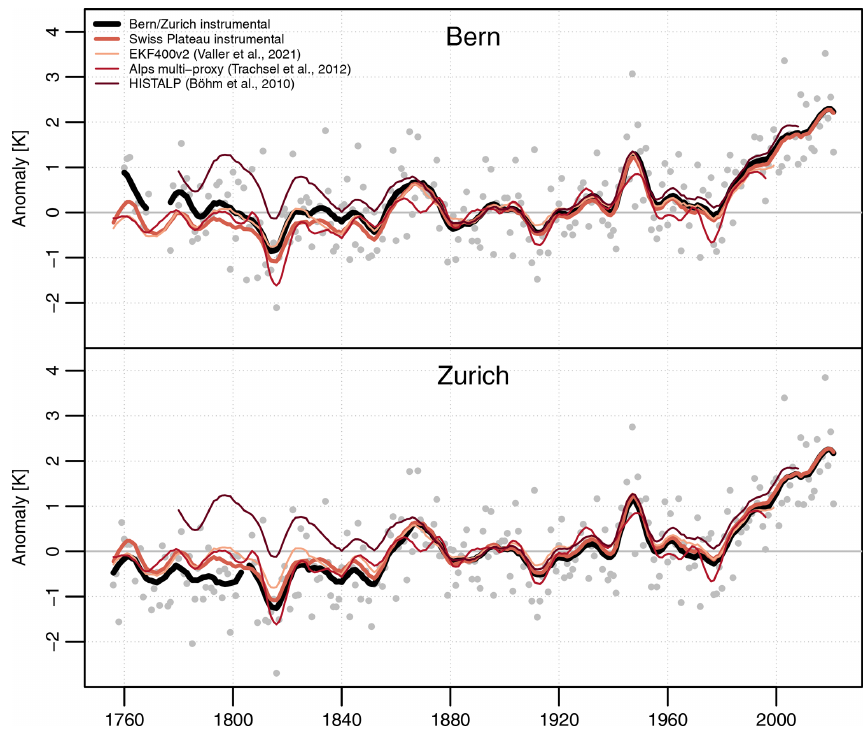
Figure 15. Smoothed time series of the warm season (April–September) mean temperature anomalies (with respect to the 1871–1900 average) for Bern and Zurich, as well as their average (thick lines). The thin lines show the warm season mean temperature anomalies from the nearest grid point in EKF400 and HISTALP, as well as the summer (June–August) temperature “mean” reconstruction from multiple proxies for the Greater Alpine Region by Trachsel et al. (2012). All data series were smoothed using a Gaussian filter with σ = 3 years. Dots represent the unsmoothed seasonal anomalies for Bern and